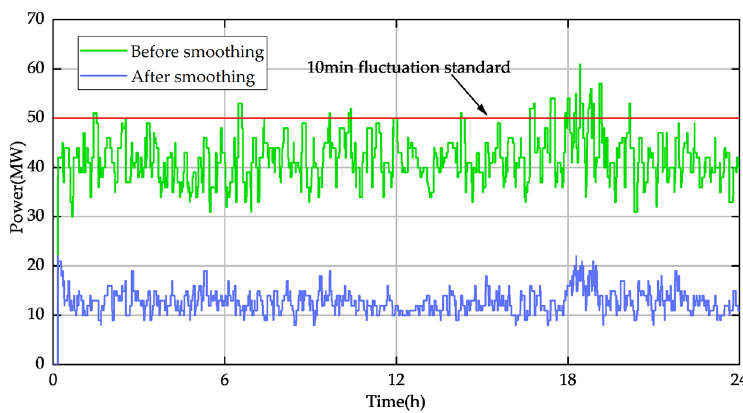
Figure 11. The amount of fluctuation before and after the 1 min smoothing.